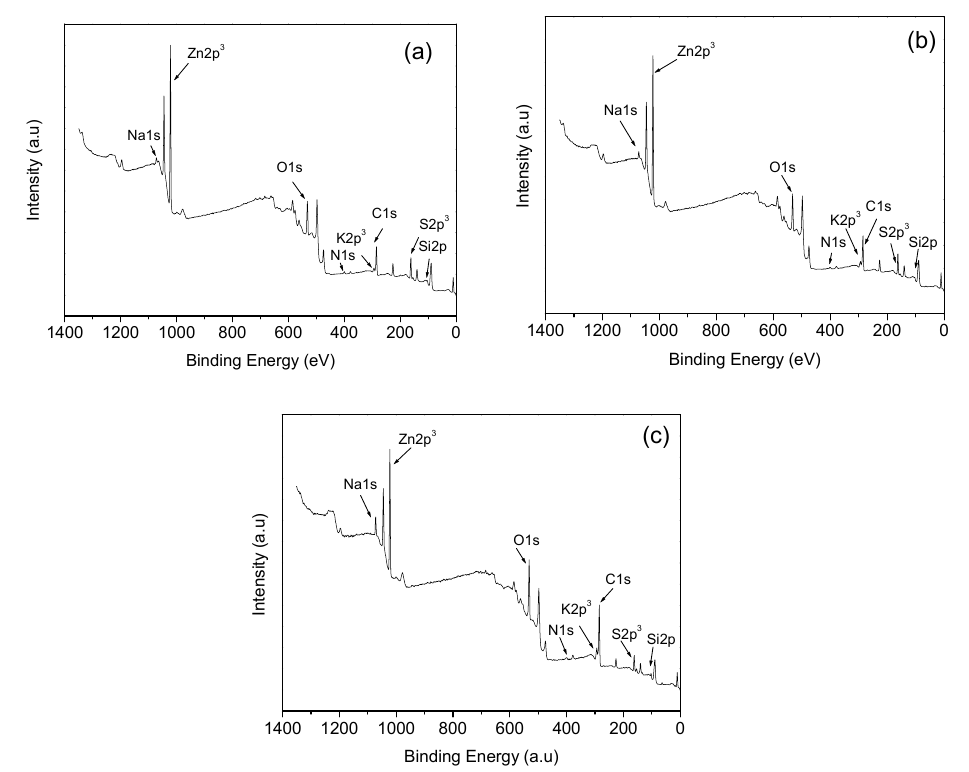
Figure 6. XPS analysis of carbon residue after selective thermal transformation for 15 min at different temperatures: ( a ) 600 °C, ( b ) 800 °C, and ( c ) 1000 °C.